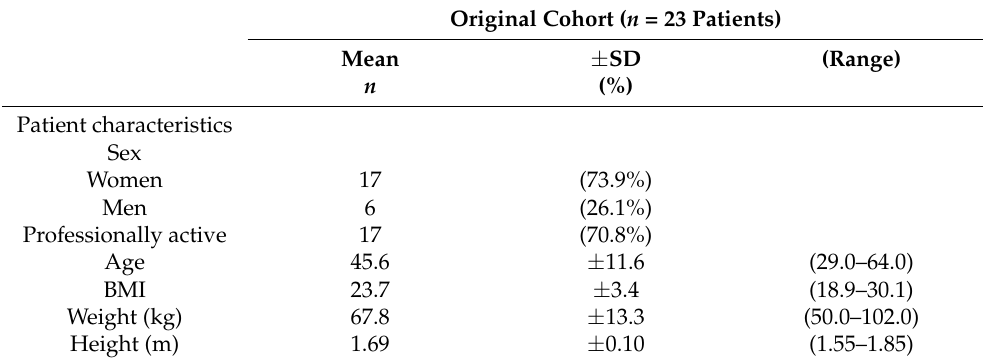
Table 1. Characteristics of the original cohort.